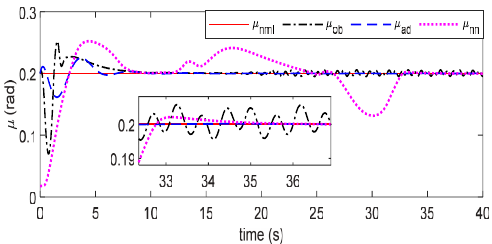
Figure 4. Tracking effects of bank angle µ